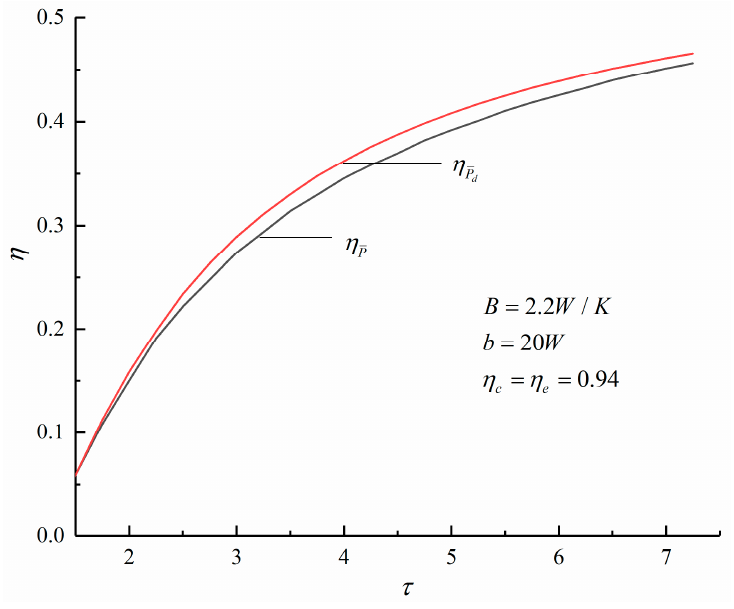
Figure 6. The curves of η versus τ .